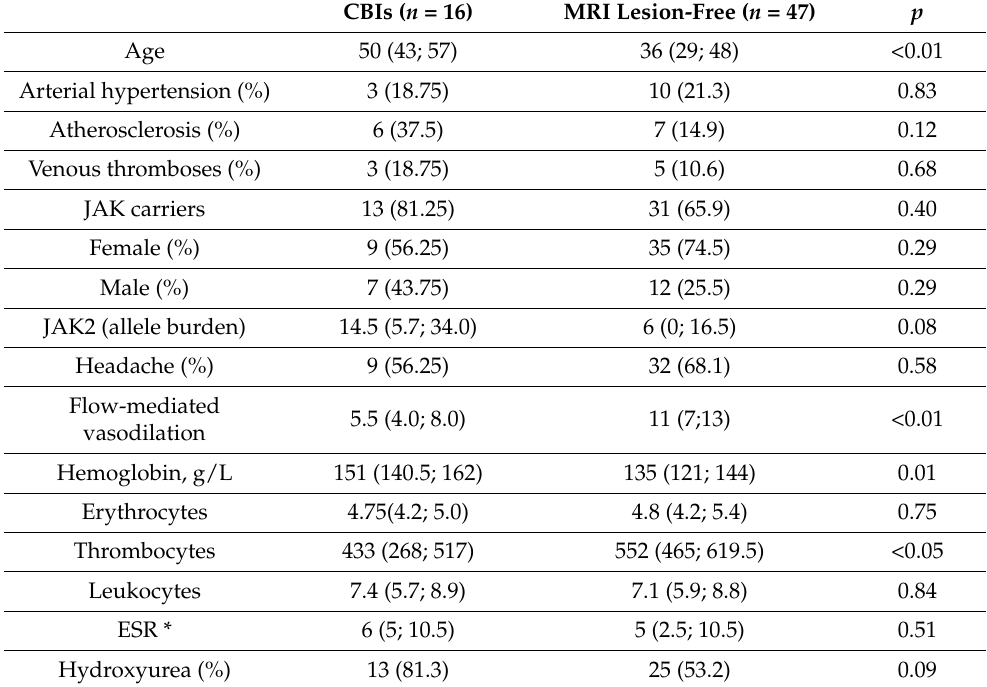
Table 2. Covert brain infarcts compared to patients without MRI ischemic